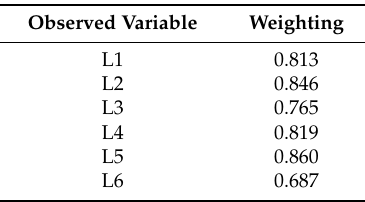
Table 4. Reliability of individual indicators